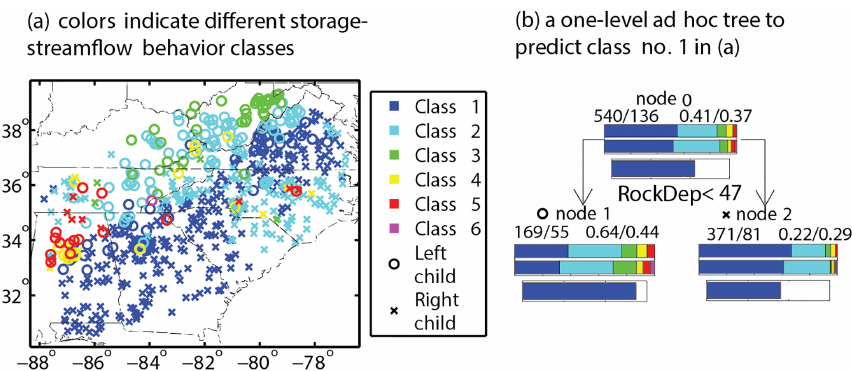
Figure 3. We calculated storage–streamflow correlation patterns over the contiguous United States (CONUS) and divided small or mesoscale basins into multiple classes. We studied which physical factors most cleanly separate different correlation patterns. Panel (a) shows the distribution of basin classes on and to the south of the Appalachian ranges. Panel (b) shows a one-level CART model that finds the most effective criterion to split basins into clusters with different distances to class #1 (storage and streamflow are highly correlated across all flow regimes) correlation patterns. This CART model does not achieve complete separation of class #1 basins, because it is based on criteria that could be established using input attributes, and there is also resolution limitation with terrestrial water storage observations, which are from the GRACE satellite. However, on a large spatial scale, what separates the blue class and the green class (low correlation between storage and high flow bands) turned out to be soil thickness. It suggests the blue basins in the south have high correlation because they have thick soils, which facilitates infiltration, water storage, and increases the importance of groundwater-contributed streamflow (Fang and Shen,